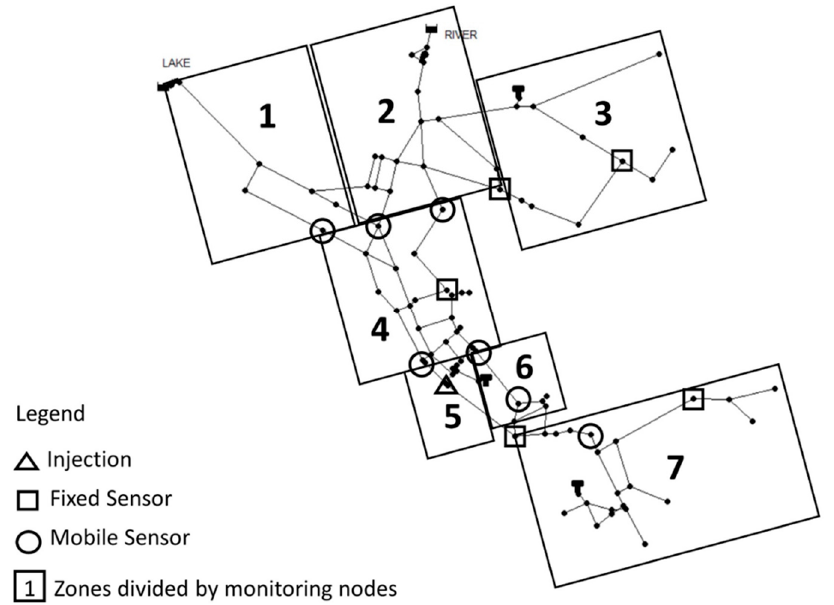
Figure 5. Division of network into zones which are monitored by mobile equipment in order to declare endangered and cleared parts of the water network.